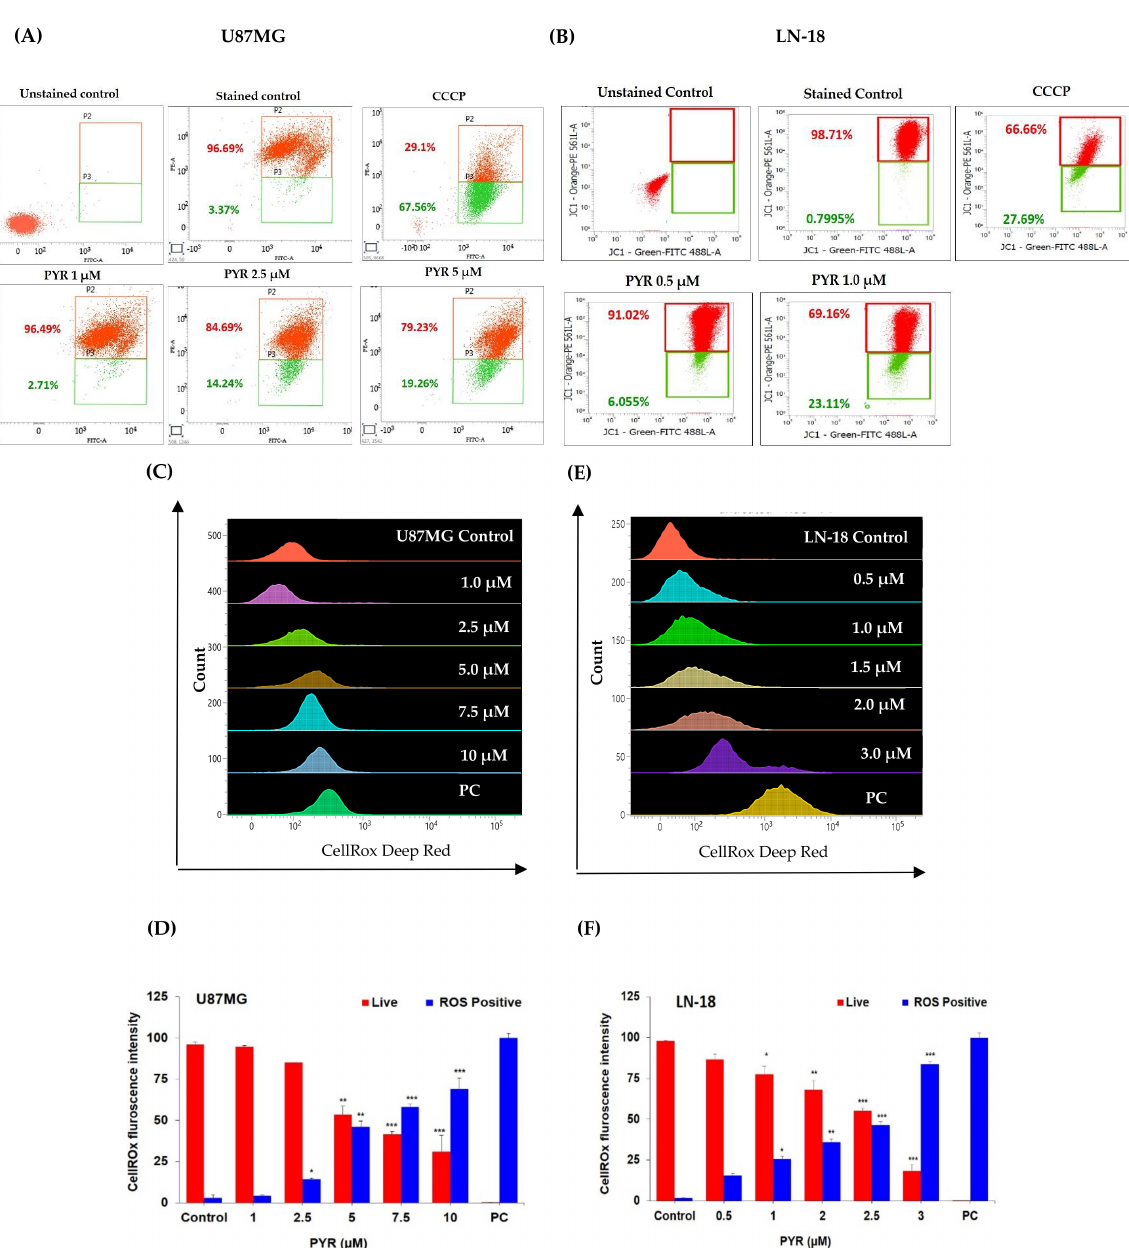
Figure 3. ( A , B ): Representative graphs for PYR-induced mitochondrial depolarization using JC-1 dye. U87MG and LN-18 (1 × 10 6 cells/mL) were treated with PYR at indicated concentrations for 16 and 24 h respectively. After treatment, cells were stained with JC-1 dye and fluorescence output was measured at 490/590 nm. CCCP (carbonyl cyanide 3-chlorophenylhydrazone) was used as a positive control. Cells were subjected to flow cytometric analysis by measuring the depolarized population of GBM cells (green color population) post PYR treatment in the lower quadrant using BD FACS Lyric. ( C – F ) Dose-dependent ROS induction in U87MG and LN-18 cells post 6 and 4 h PYR treatment respectively. The ROS levels were measured by determining Cell ROX Deep Red fluorescence intensity via flow cytometry at an emission/excitation of 640/665 nm. ( D – F ) The histogram depicts the trend of Live cells (red bar) and ROS-positive cells (blue bar) in GBM cells post PYR treatment. The data shown are mean ± SD ( n = 2). Statistical analysis was performed using one-way ANOVA followed by a post hoc by Tukey test. The statistically significant difference for control v/s specific group is represented as * p ≤ 0.05, ** p ≤ 0.01 and *** p ≤